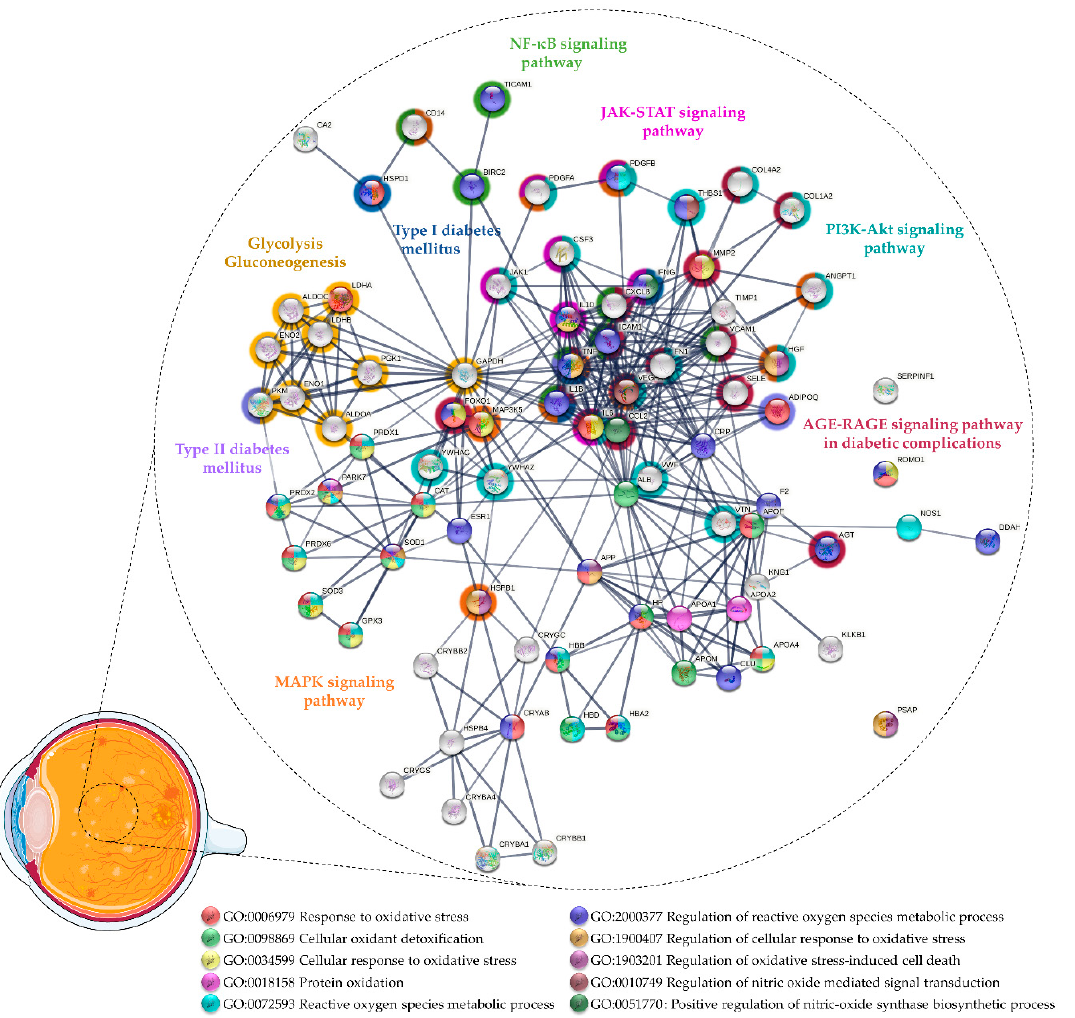
Figure 1. Protein–protein interaction network of the proteins related to oxidative stress found differentially expressed in vitreous collected from patients with DR and proliferative DR (PDR). The network was predicted using STRING 11.5 based on high confidence interaction score and clustered using the Markov Cluster algorithm clustering (inflation parameter: